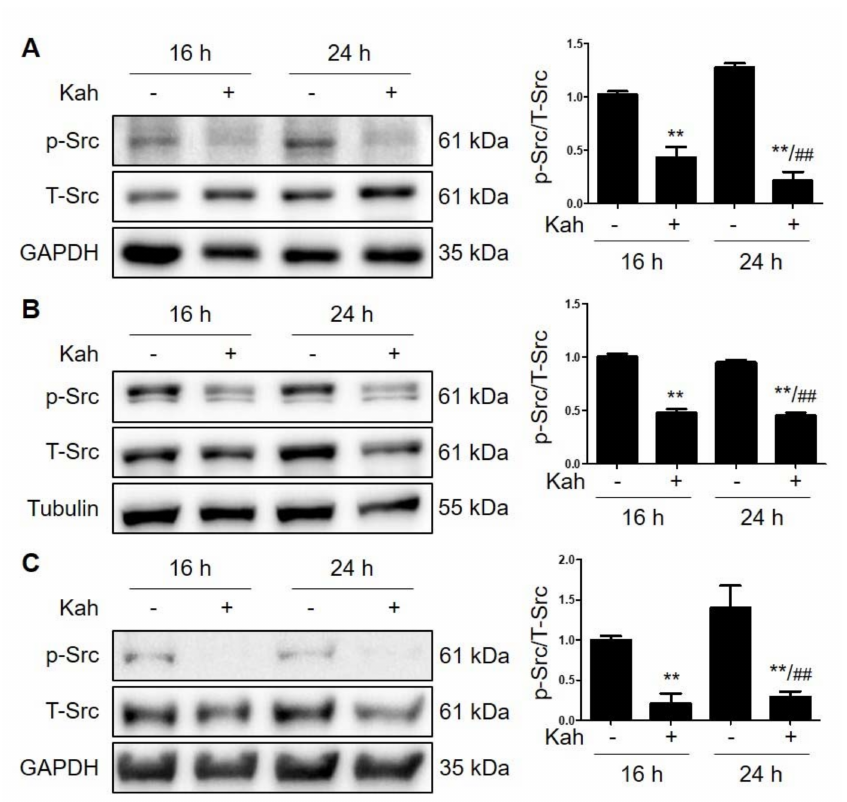
Figure 4. Kahweol decreases the level of p-Src expression in HCC cells. ( A ) Hep3B, ( B ) SNU182, and ( C ) SNU423 cells were treated with 40 µ M kahweol for 24 h. Western blot analyses show the effects of kahweol on p-Src expression levels. Data in the graph are represented as the mean ± SEM of three independent measurements, and graphs are normalized to 16h control (without kahweol). ** p < 0.01 relative to the 16 h control. ## p < 0.01 relative to the 24 h control (without